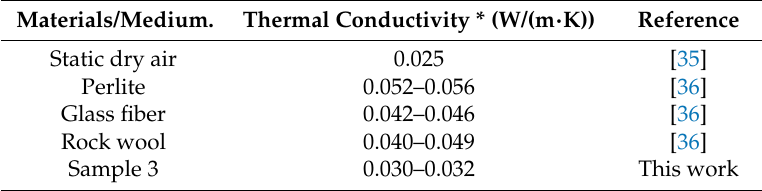
Table 5. Comparison of the thermal conductivity of different thermal insulation